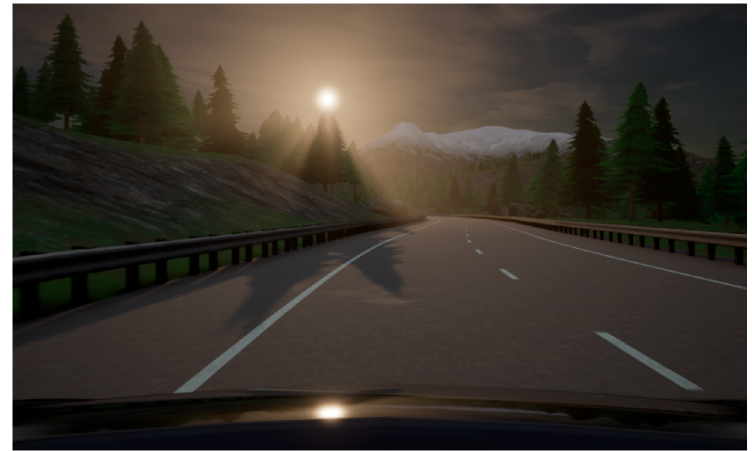
Figure 13. Mobileye 6 view of a curve subject to LKA.